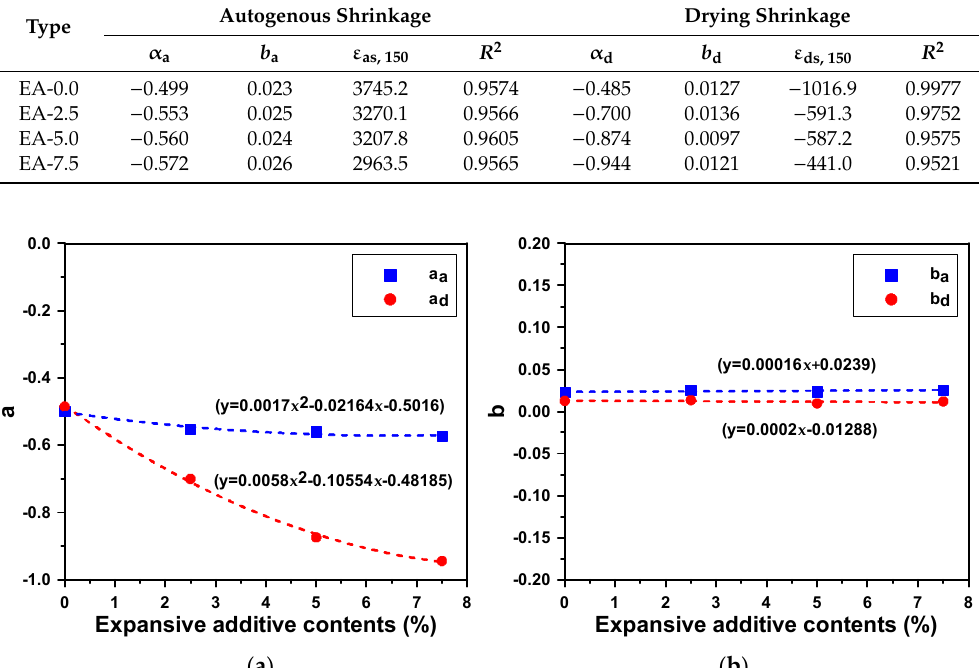
Figure 4. Relationships between the expansive additive content and material coefficients of the shrinkage model: ( a ) for coefficient “ α ”, and ( b ) for coefficient “ b ”. model: ( a ) for coefficient “ α ”, and ( b ) for coefficient “ b